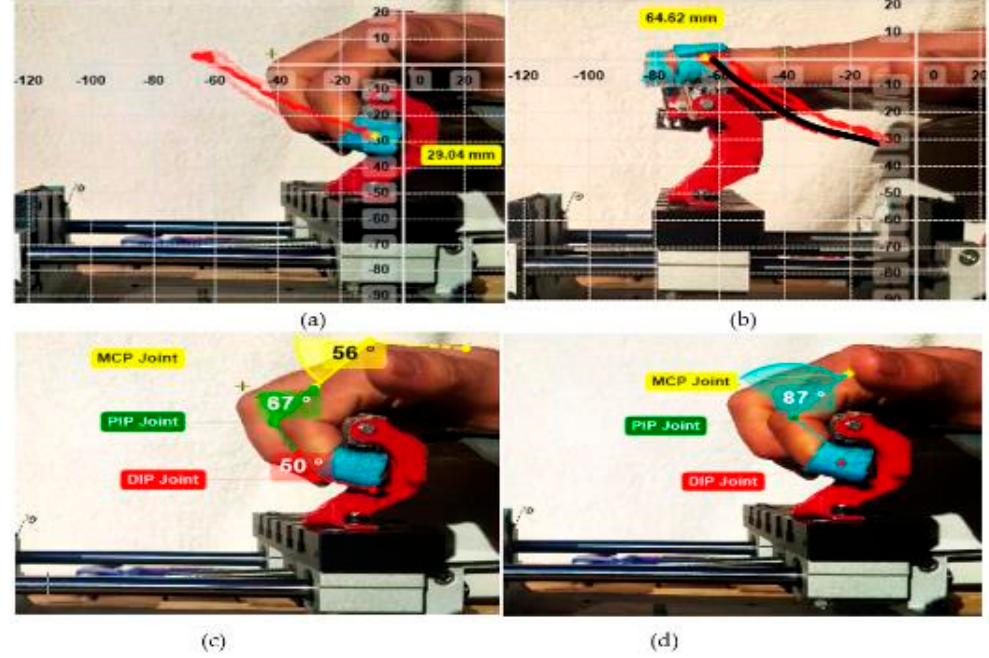
Figure 11. A real-time experimental setup of the index finger’s workspace trajectories measurement: ( a ) Index finger fixation actual range of motion (ROM) angle, workspace trajectory, and position caused by FWRMS. ( b ) index finger extension actual (black curve) and desired (black curve) workspace trajectory. ( c ) Index finger joints (MCP, Distal Interphalangeal PIP, and Proximal Interphalangeal DIP) grasping ROM. (d) the overall grasping angle of the index finger.